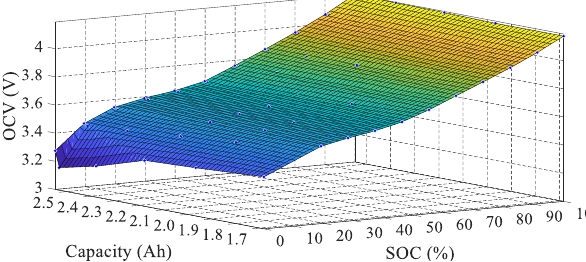
Figure 5. The three-dimensional response surface via capacity – SOC – OCV.